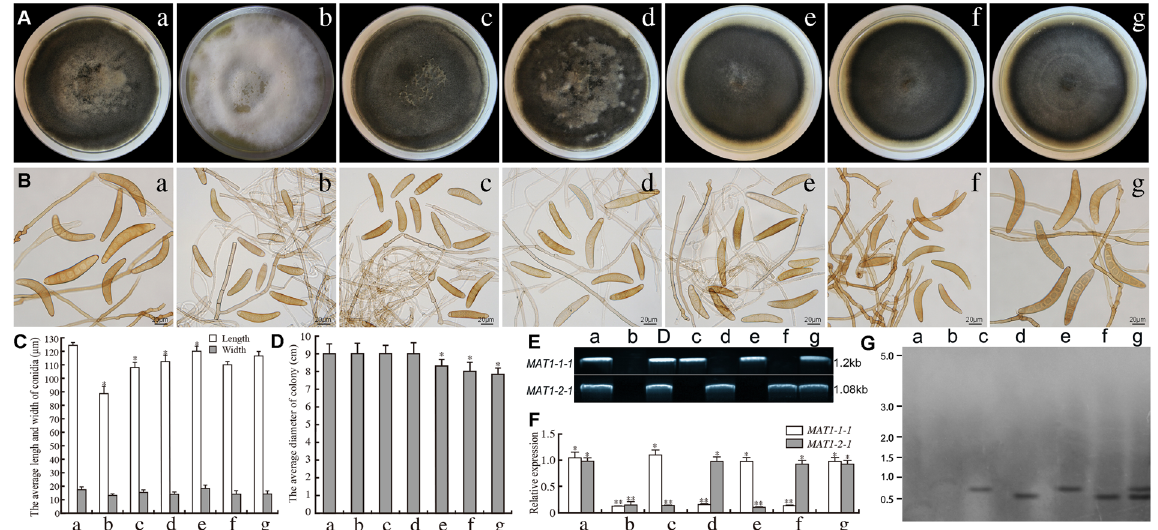
Figure 3. Effect of transformation of U. botrytis MAT genes on asexual morphology of C. heterostrophus C4- 41.7 (MAT-0). ( A , D ) Growth and diameter of the colonies of the different strains at 12 days after incubation. Colony growth rates were determined from at least 25 plates. ( B , C ) Variation in conidial size. L = Length, W = Width. The average size of conidia was determined from at least 50 conidia. Photographs were taken 12 days after incubation. ( E ) RT-PCR analysis of the transcription of MAT genes in different transgenic lines. D-DNA template of WT. ( F ) qRT-PCR analysis of mRNA expression levels of MAT1-1-1 and MAT1-2-1 in individual heterologous transgenic lines as described above, relative to the constitutive control lines. C. heterostrophus strains 2847, C4-41.7 (MAT 0 ), 2829 and 2849 were used as negative controls. Actin was used as a positive control. Error bars represent standard errors calculated using three biological replicates for each sample. ‘ * ’ indicates a significant difference from WT ( P < 0.05) using a Student’s t - test . ‘ ** ’ indicates a significant difference from WT ( P < 0.01) using a Student’s t-test . ( G ) For Southern blot analysis, both hygB and G418 specific probes were used to detect transgene insertion as shown in Table S1. WT and WT1 have no hygB and G418 specific insertion. a WT is C. heterostrophus (2847). b WT1 is C. heterostrophus C4-41.7 (MAT-0). c WT2 is C. heterostrophus C5 (2829). d WT3 is C. heterostrophus C4 (2849). e Ch Δ mat0 { UbMAT } -2 . f Ch Δ